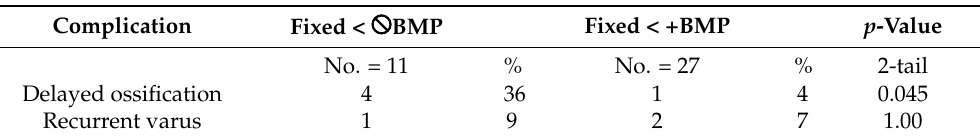
Table 4. Comparison of complications in primary SH: non-fixed angle + no BMP2 (group 1) vs. fixed angle + BMP2 (group 3). Table 3. Comparison of complications in primary SH: Fixed angle + no BMP2 (group 2) vs. Fixed angle + BMP2 (group 3). Table 5. Comparison of complications in revision SH: fixed angle + no BMP2 (group 2) vs. fixed angle + BMP (group 3).